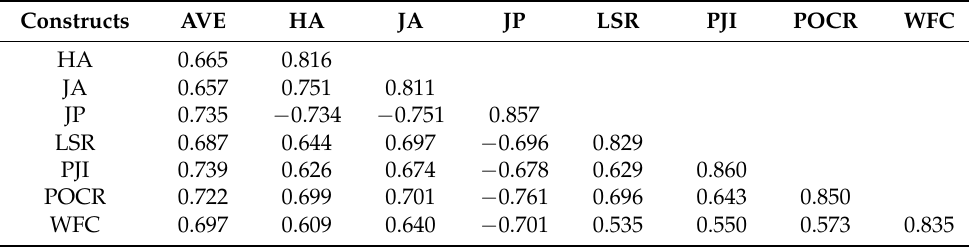
Table 3. Discriminant-validity analysis (Fornel–Larcker).